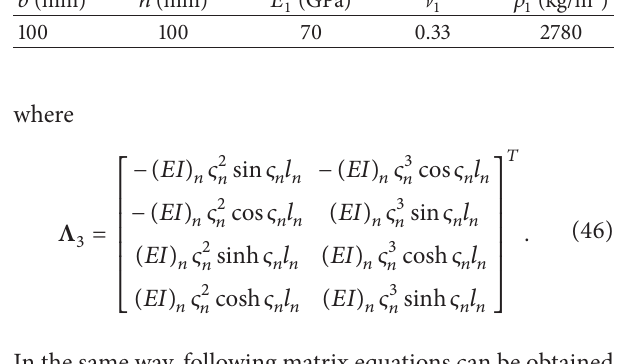
Table 1: The material and physical parameters in [27]. Table2:Thefirstthreenondimensionalnaturalfrequenciesofintact FGM